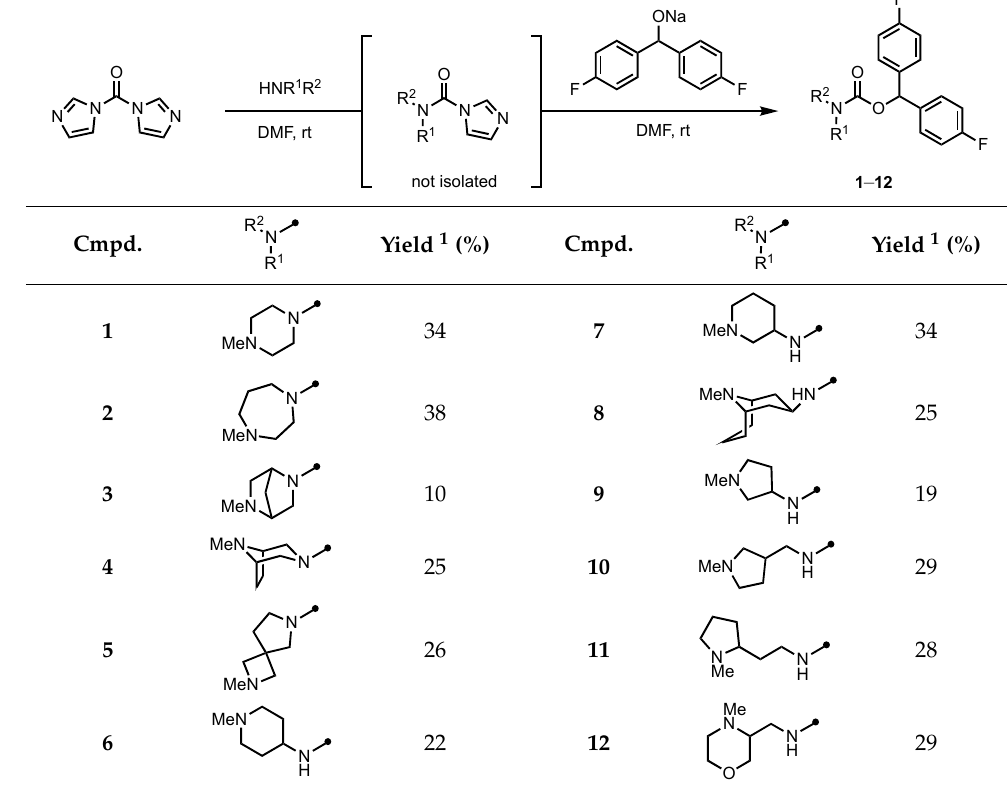
Table 1. General synthetic route towards carbamates 1 – 12 .